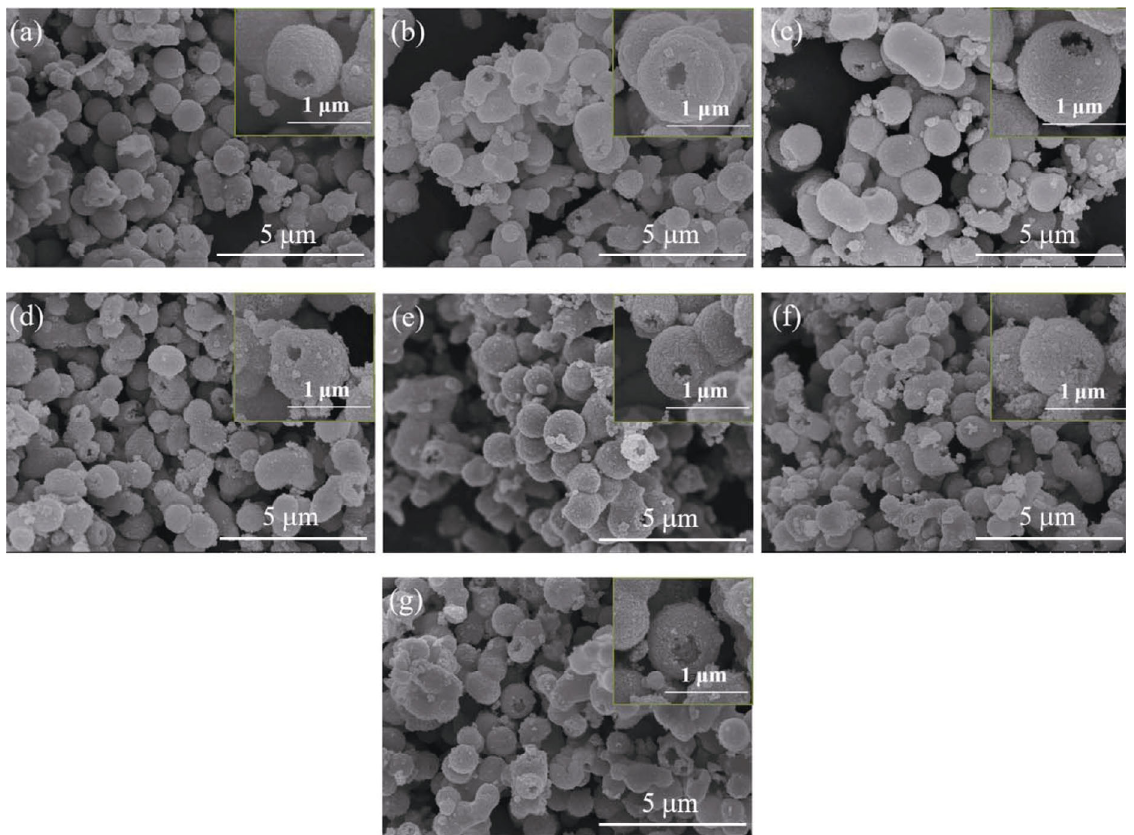
Fig. 4 SEM images of (a) In 2 O 3 , (b) 1Ag–In, (c) 2Ag–In, (d) 3Ag–In, (e) 4Ag–In, (f) 5Ag–In, and (g) 6Ag–In samples (the insets are the corresponding high magnification